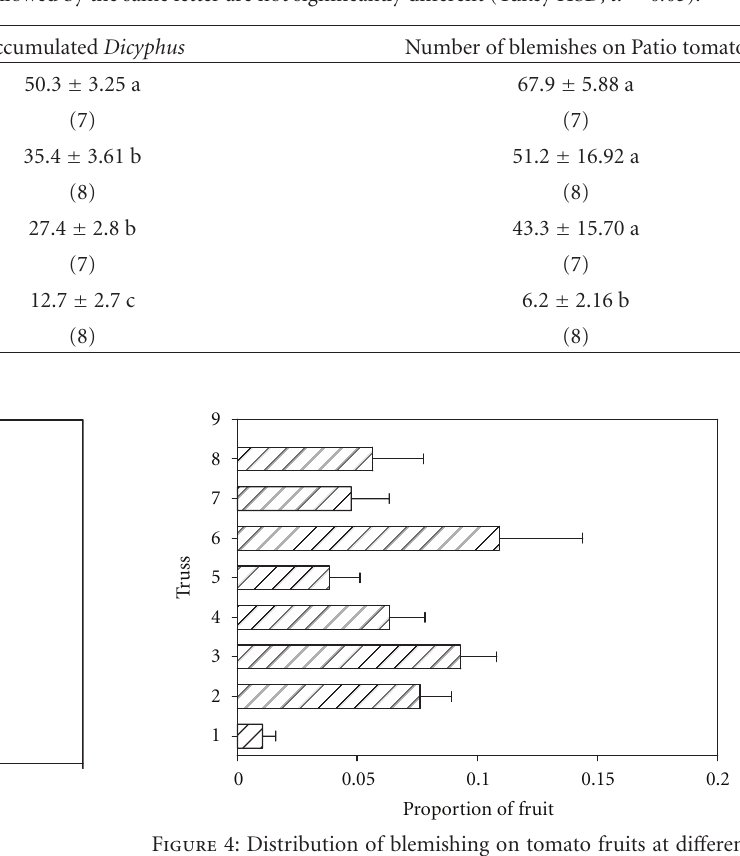
Table 4: Mean ± SE ( N ) accumulated numbers of D. hesperus on Patio tomato plants and number of blemishes on fruit in the presence of di ff erent alternative plant species. Means in columns followed by the same letter are not significantly di ff erent (Tukey HSD, α = 0 . 05).